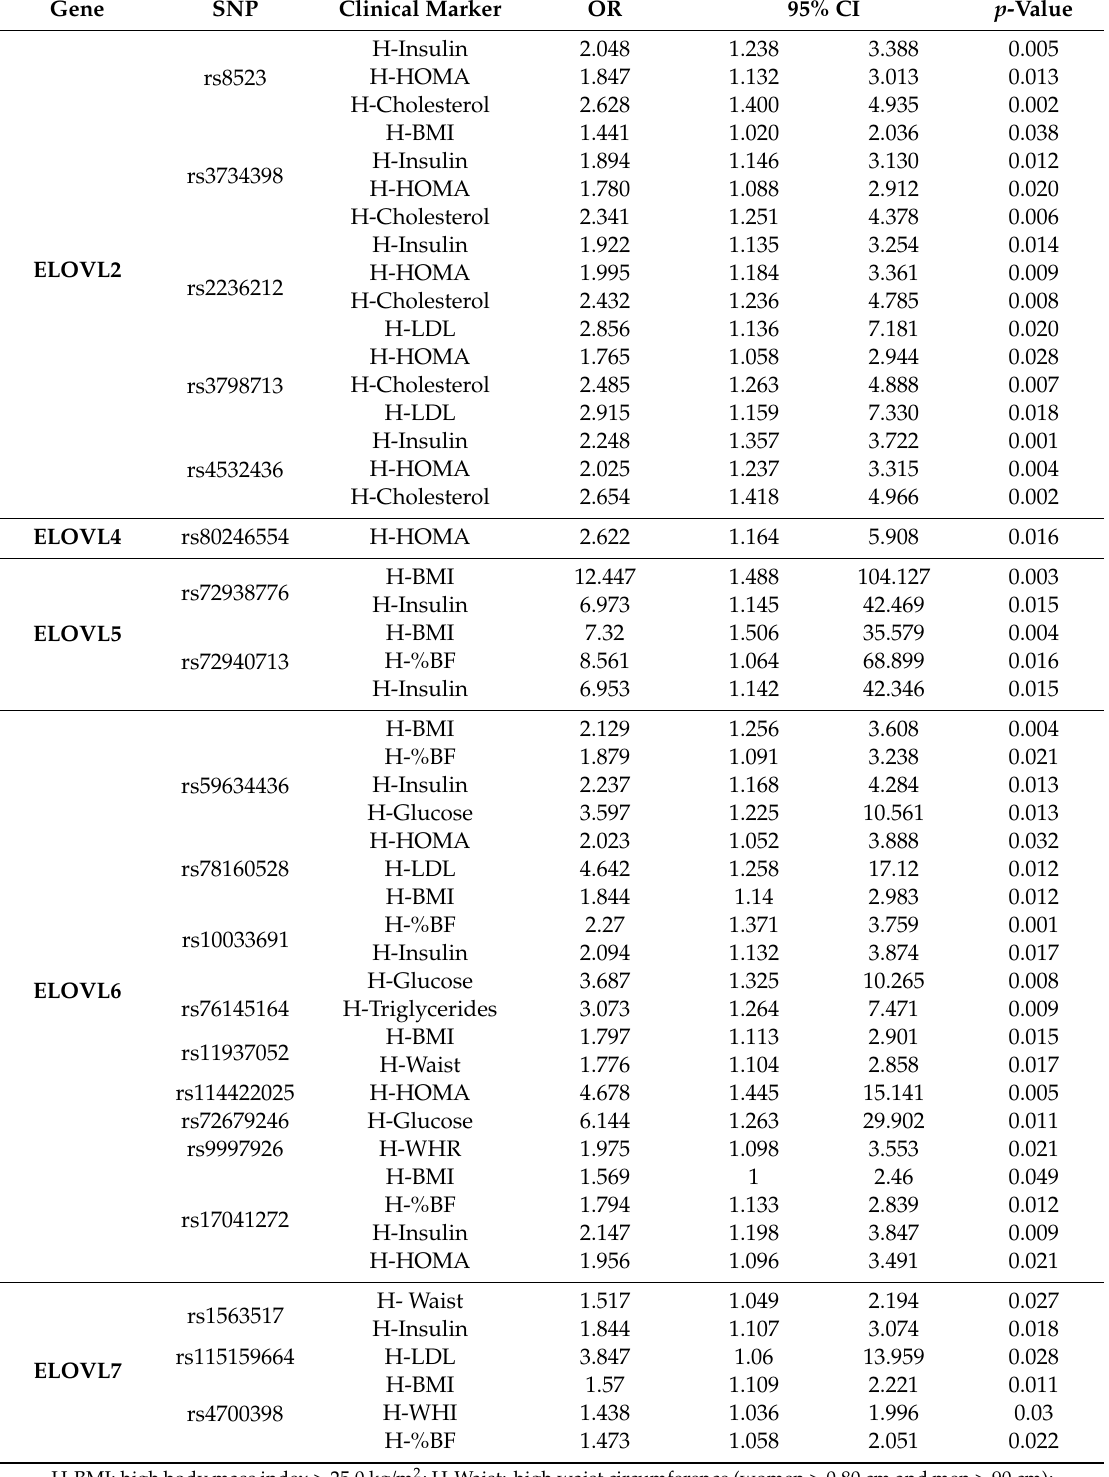
Table 4. Association between SNP of elongases of very long chain fatty acids (ELOVL) and clinical markers of chronic non-communicable diseases (risk